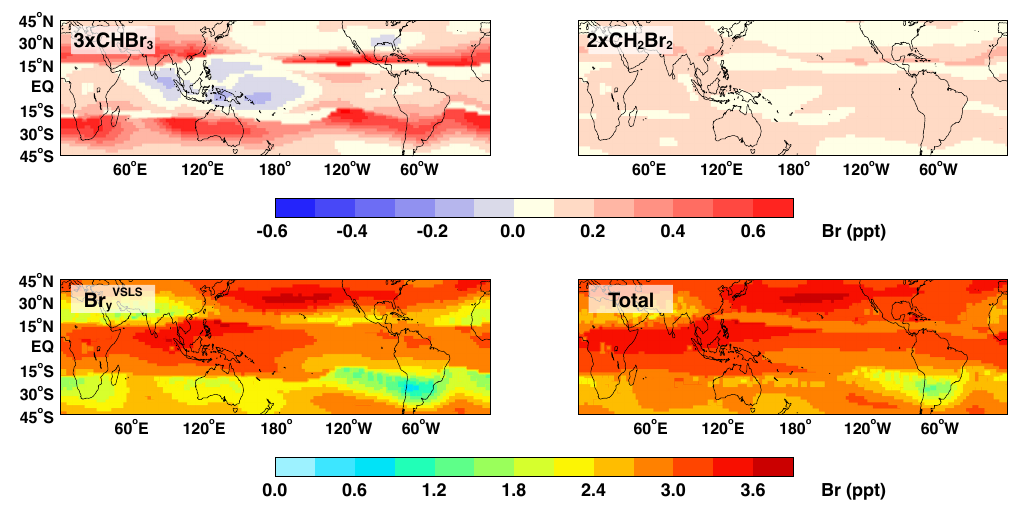
Figure 8. The simulated annual mean difference between the R MINCNV and R MAXRUN runs in organic bromine (3 × CHBr 3 , 2 × CH 2 Br 2 ), inorganic bromine, and total bromine from VSLSs between 355 and 380K. The model results are 10-year annual averages from 2001 to